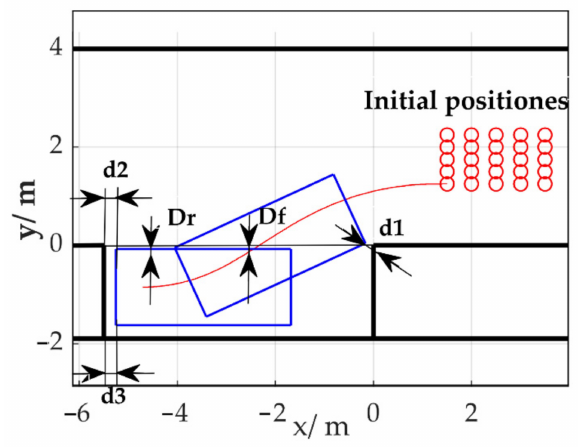
Figure 6. Simulation and experimental environment setup in the parking co-ordinate system (Dr and Df are the distances from rear and front tyres to the parking space edge; d2 and d3 are the distances from left and right corners to the rear obstacle; d1 is the minimum distance to the front